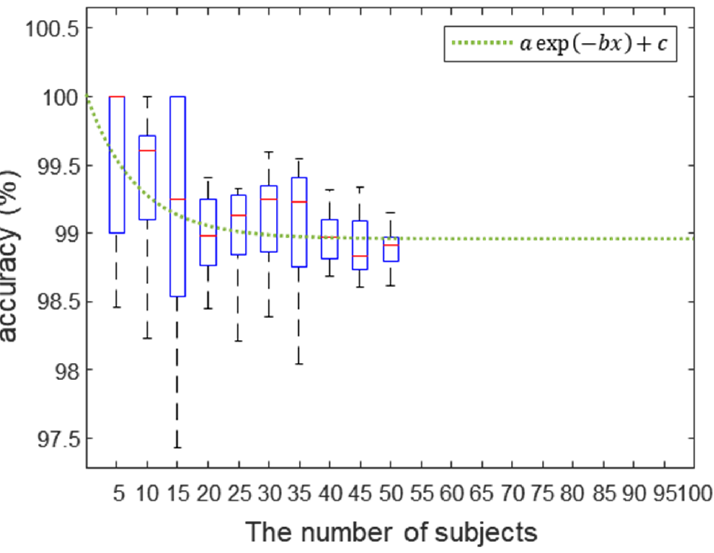
Figure 11. The boxplots of the accuracy according to the number of subjects. Each classification accuracy for the selected dataset. The green dotted line represents the accuracy prediction curve as the number of subjects increases. The inset equation’s parameters were 1.056, 0.1194, and 98.96 for a, b, and c, respectively.